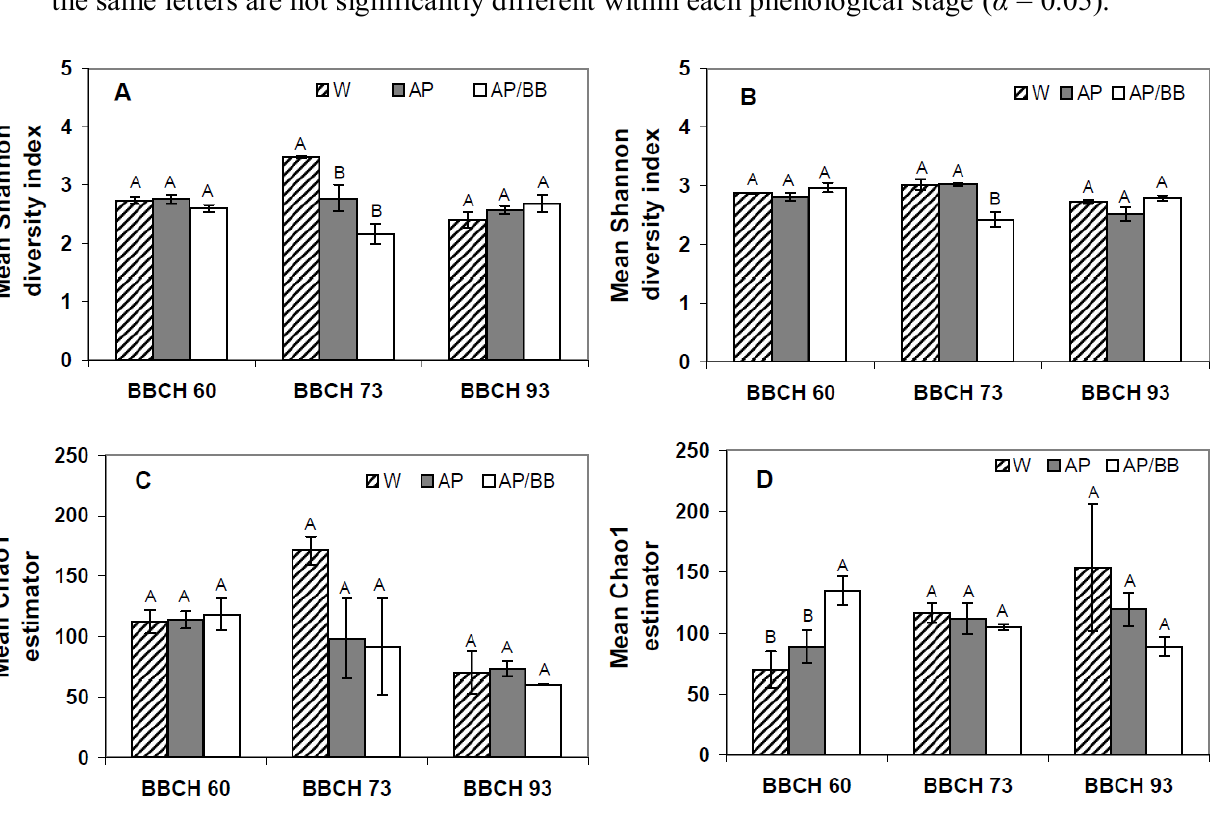
Figure 4. Shannon diversity indices and Chao1 estimators describing the biodiversity and taxa richness of fungal phyllosphere communities at three distinct phenological stages (BBCH 60, BBCH 73, and BBCH 93) as influenced by treatments with Aureobasidium pullulans as a single strain treatment (AP) or co-inoculated with Beauveria bassiana (AP/BB) in 2011 ( A , C ) and 2012 ( B , D ). The control (W) was treated with water from a lotic reservoir. Error bars represent SEM values. Columns marked with the same letters are not significantly different within each phenological stage ( α =